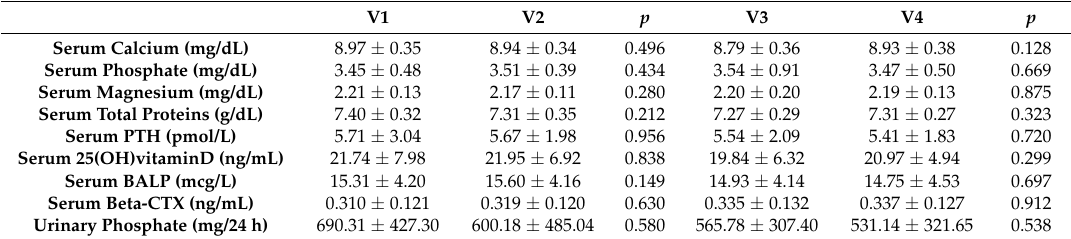
Table 4. Biochemical characteristics of mineral and bone metabolism of the entire study group ( n = 27) evaluated during a 9 week study period. V1 V2 p V3 V4 Serum Calcium (mg/dL)